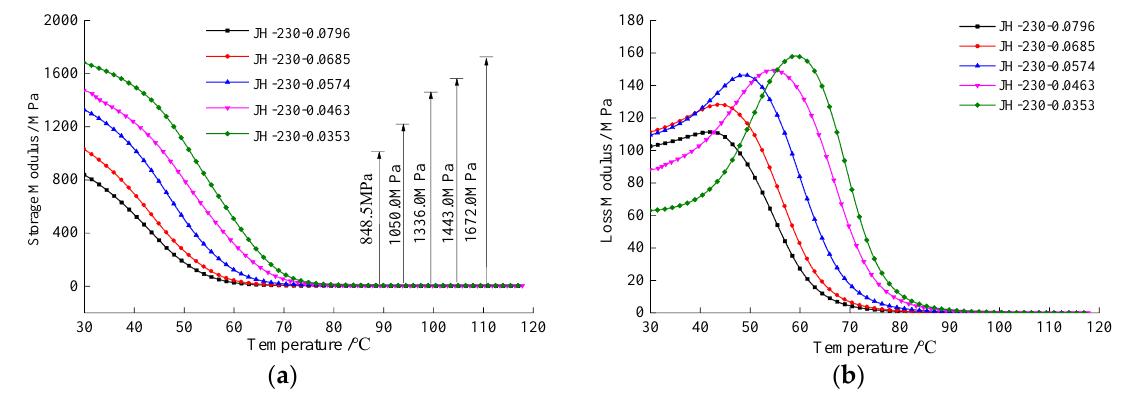
Figure 10. Dynamic mechanical analysis (DMA) curves of the SM-HEP-AM: ( a ) the storage modulus; and ( b ) the loss modulus.